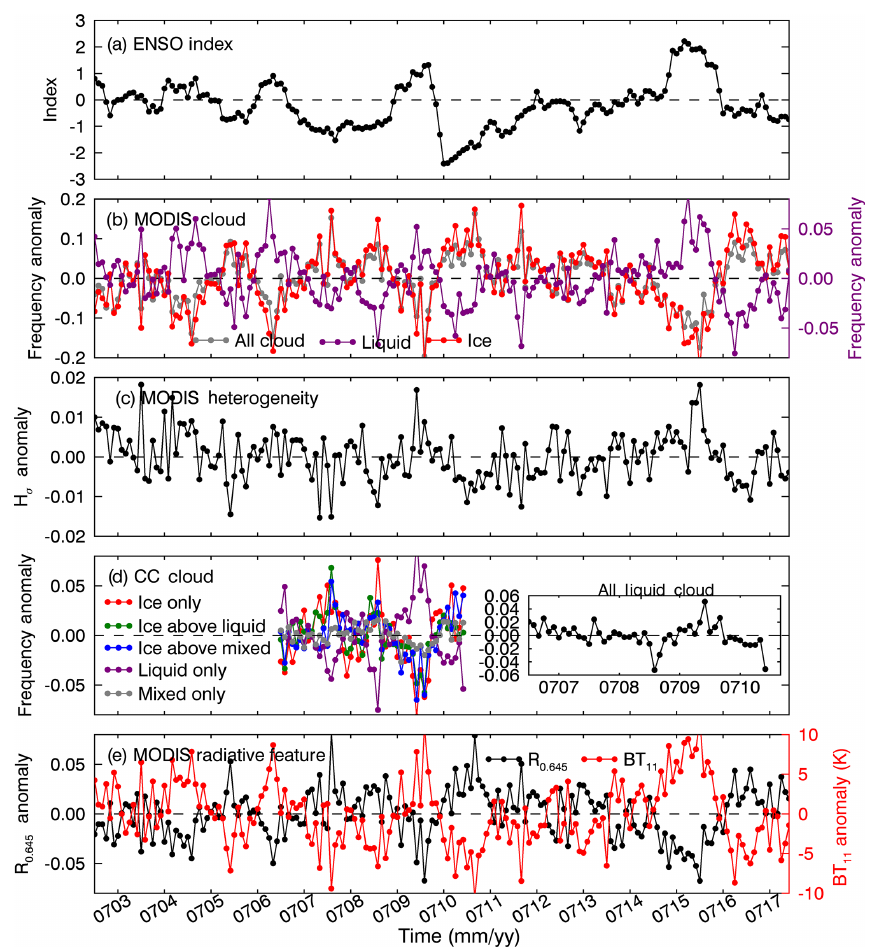
Figure 14. ENSO index and monthly anomaly of cloud, spatial heterogeneity, and radiation in the region represented by the dashed red box in Fig.